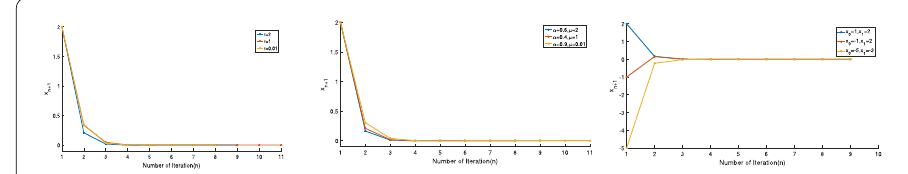
Figure 1 Results of Algorithm 3.1 for different parameters in Example